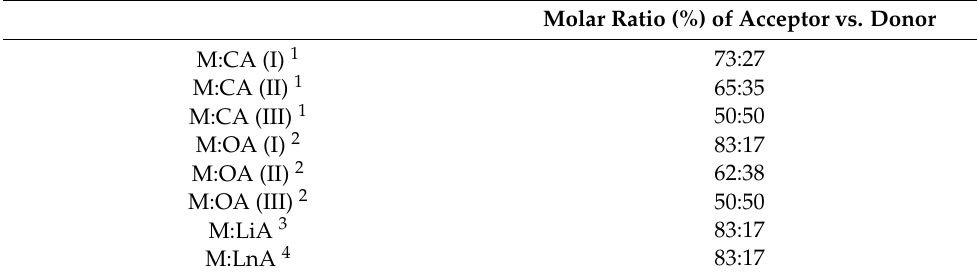
Table 1. DES composition based on L -menthol and fatty acid components. Molar Ratio (%) of Acceptor vs.